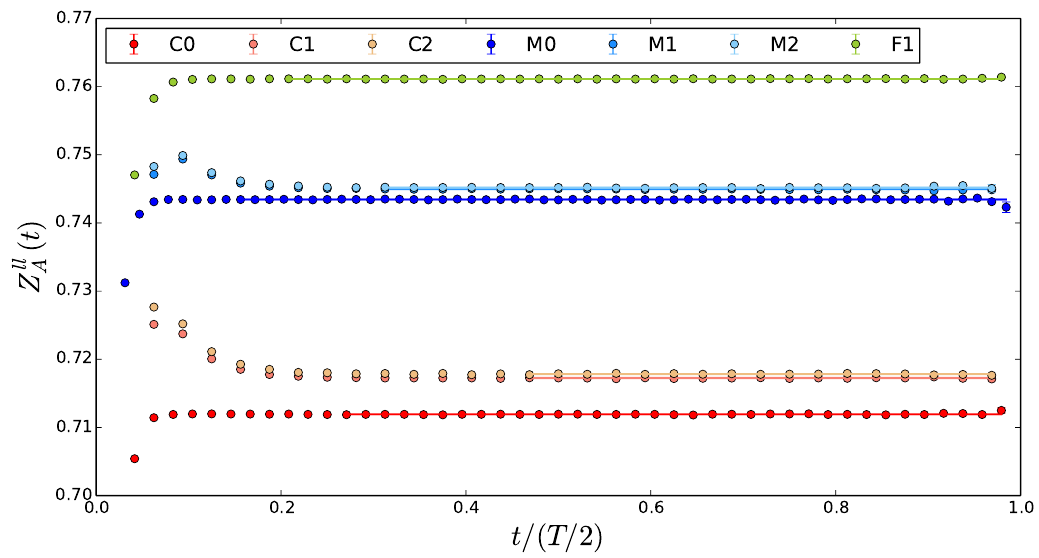
Figure 5 . The time behaviour of Z e(cid:11) ( t ) scaled to the interval [0 ; 1] for all ensembles. The solid A lines correspond to the (cid:12)t results obtained by (cid:12)tting a constant to the plateau region of the data. The (cid:12)t results are summarised in table 4.